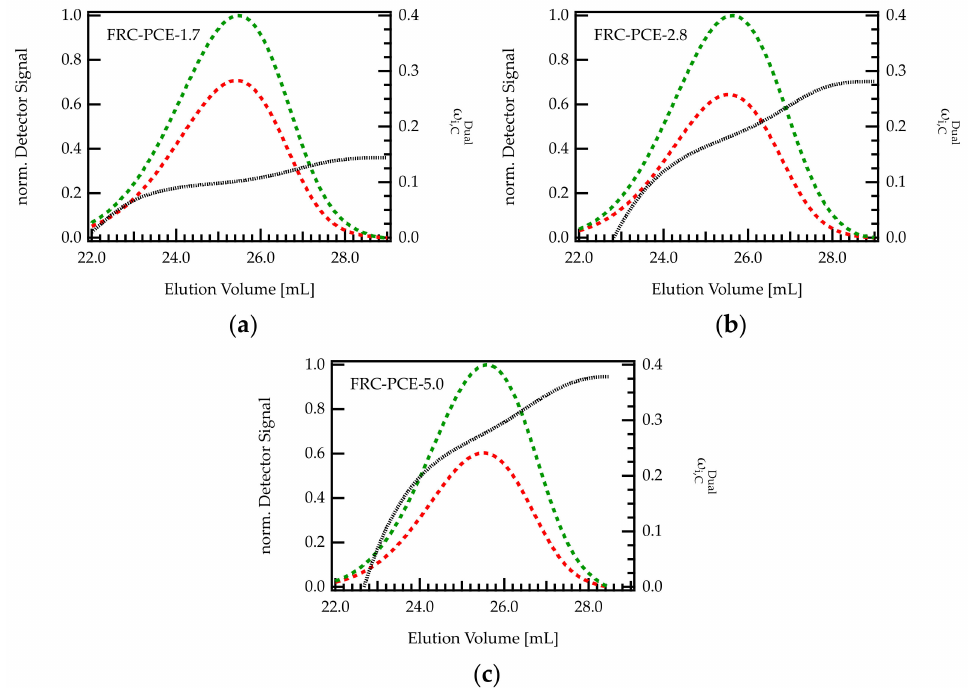
Figure 7. ( a – c ) Chromatogram of various FRC-PCE samples with different C/E ratio. The green curve is the UV signal, and the red curve corresponds to the RI signal. The signals were normalized with regard to the maximum of the UV peak. The dashed black line indicates the composition of the eluting species monitored by dual